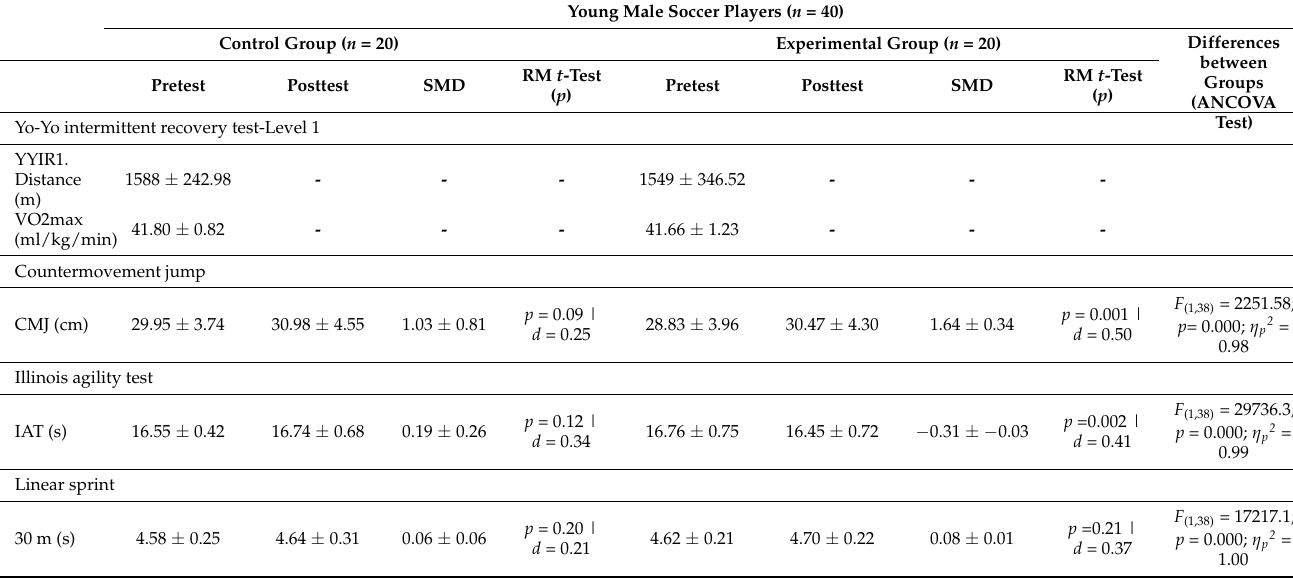
Table 2. Performance variables before (pretest) and after (posttest) the intervention period (mean ± SD).